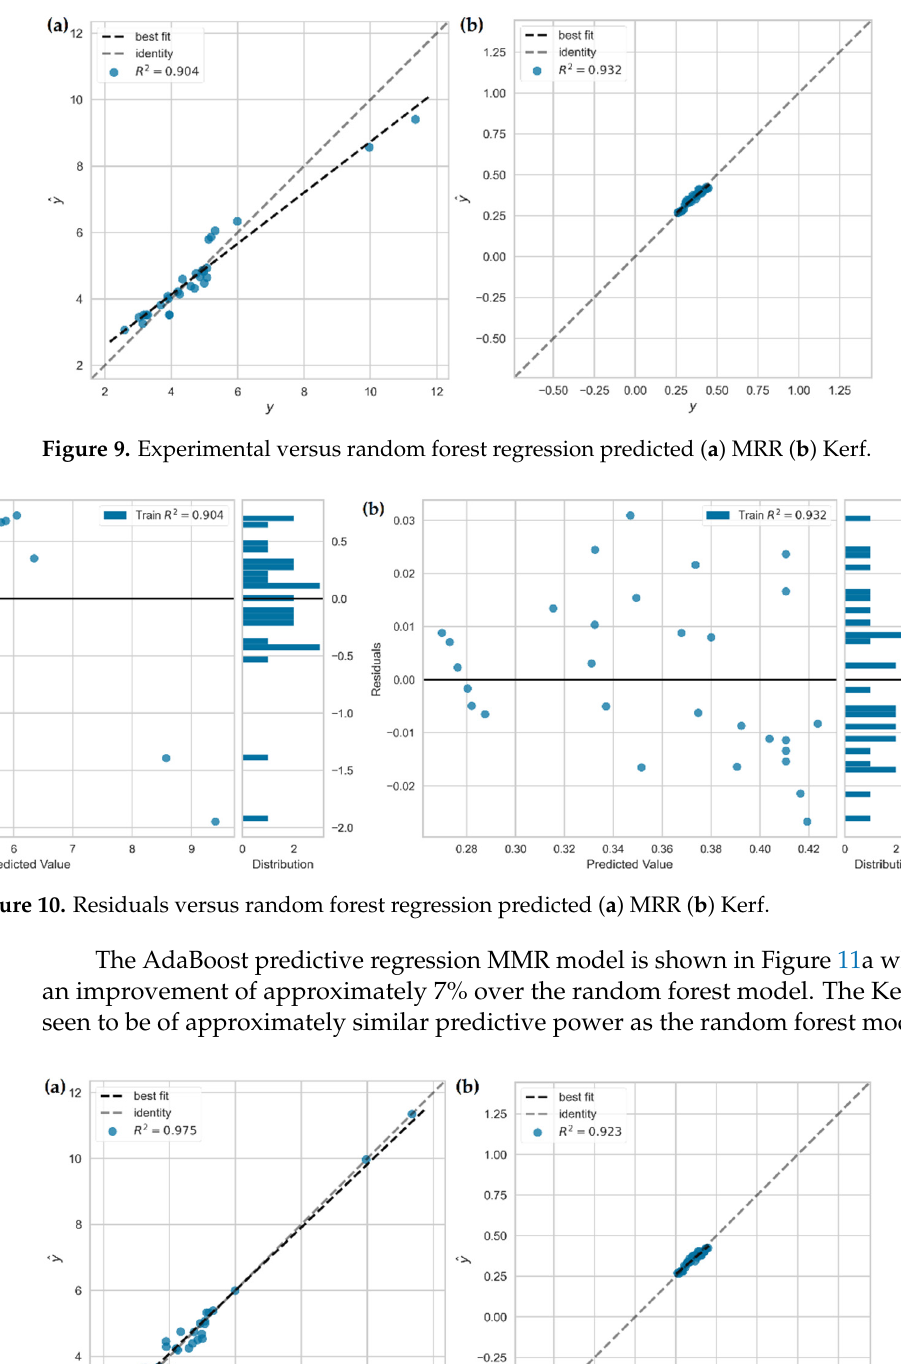
Figure 12. Residuals versus AdaBoost regression predicted ( a ) MRR ( b ) Kerf. 4. Conclusions Non-traditional machining processes find tremendous use in the modern manufac- turing sector primarily due to their ability to machine conventionally hard-to-machine materials. These NTMs depend on various technological process parameters that must be carefully calibrated to obtain the desired performance. However, owing to the expensive nature of the physical experiments, it is not always possible to apply a brute force ap- proach to find the best possible combination of process parameters. In real-world situa- tions, even before proceeding to the optimization phase, accurate estimations of the re- sponses must be carried out. In this paper, two case studies on EDM and WEDM are illustrated to highlight the potential of machine learning in building accurate predictive models. Scatter plots of the process parameters and the responses were used to ascertain the presence or absence of any general trend of association. Correlation heat maps between the various process pa- rameters indicate the lack of any multicollinearity. Also, correlation heat maps between the process parameters and the responses helped in identifying any linear trend in be- tween them. Three popular ML algorithms, namely linear regression, random forest regression and AdaBoost regression, are considered for the task. Several error metrics are used to highlight the effectiveness of each ML model. Based on the comprehensive evaluation of the two case studies it is observed that though linear regression is simple and quick, it falls short of accurately mapping the complex interaction between the process parameters and the responses. On the other hand, random forest regression and AdaBoost regression showed remarkable accuracy on all the problems. Generally, AdaBoost regression was found to be marginally superior to random forest regression in terms of accuracy. How- ever, the insensitiveness of AdaBoost on the number of regressors makes it a time-saving